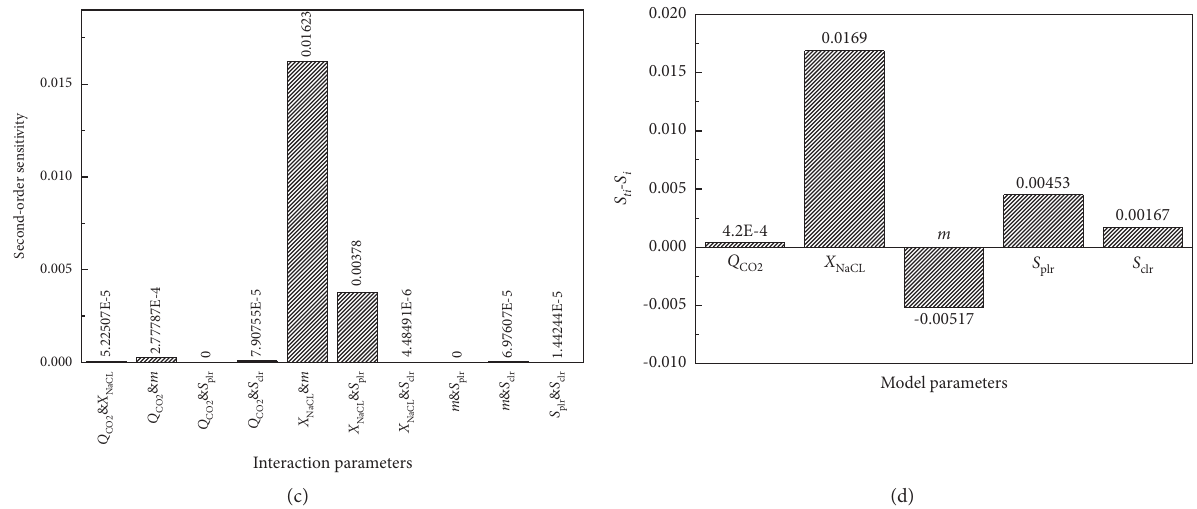
Figure 14: Sobol global sensitivity analysis of S s near the injection well: (a) first-order and total sensitivity coefficients of the salting-out model in Wang et al. [32]; (b) set: 2,000, first-order, and total sensitivity index of the salting-out model with 14,000 simulations; (c) second- order sensitivity coefficient of the salting-out model in Wang et al. [32]; (d) interaction effect for all